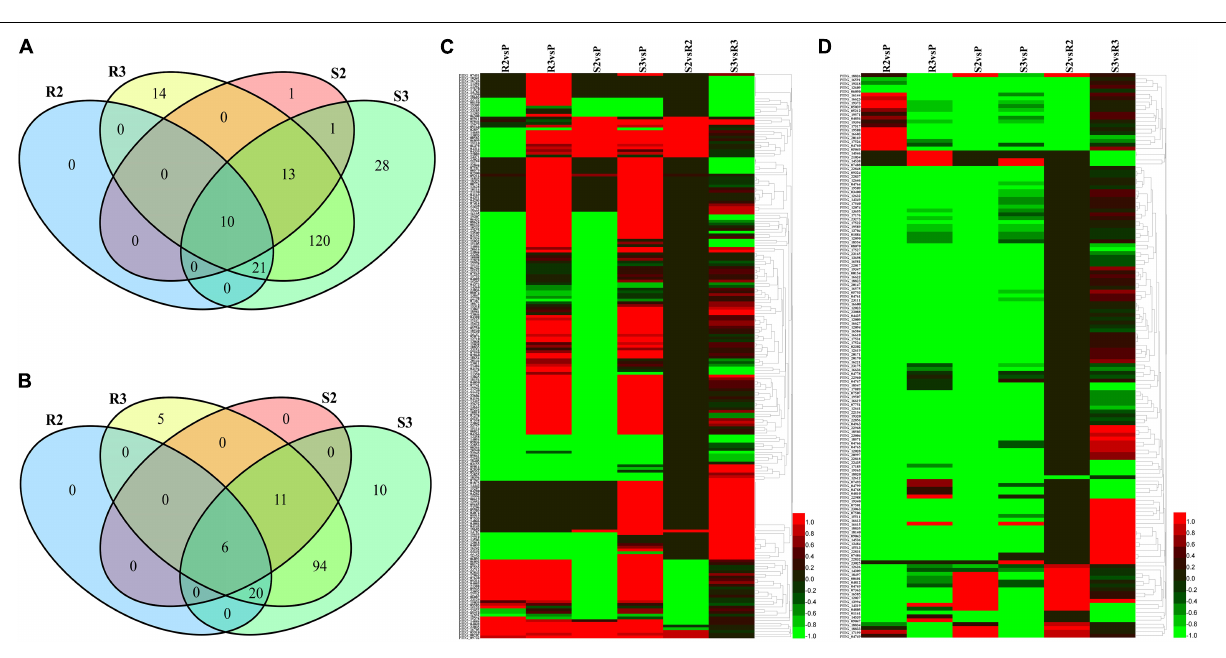
FIGURE 4 | Expression patterns of the effector genes in P. infestans during the infection. The log 2 FC values were calculated based on the expression levels and used to draw heatmaps by HemI (version 1.0) (Deng et al., 2014). (A) Venn diagram of the 208 Arg-X-Leu-Arg (RXLR) effector genes. (B) Venn diagram of the 146 RXLR effector genes. (C) Heatmap of the 208 RXLR effector genes. (D) Heatmap of the 146 CRN effector